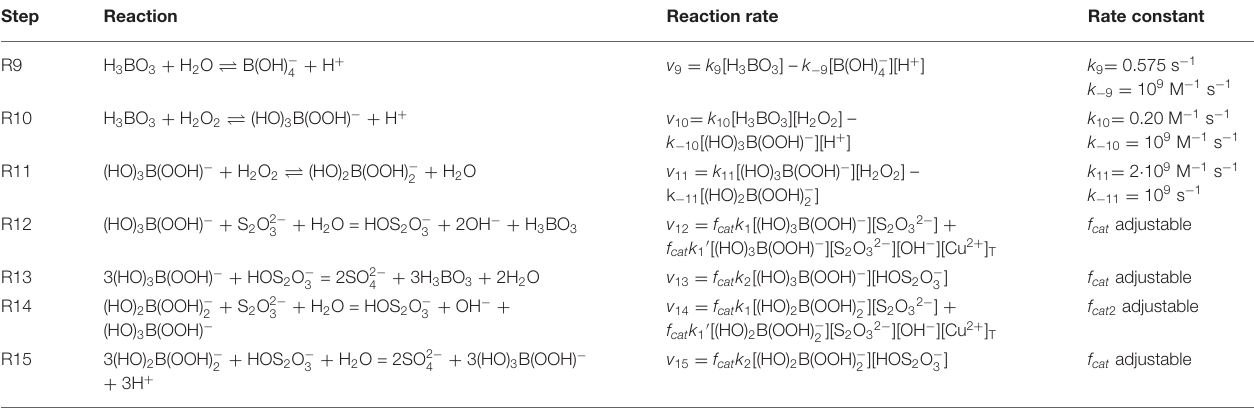
TABLE 2 | Reactions of the boron species related to the H 2 O 2 –S 2 O 2 − 3 –Cu(II) system. Step Reaction